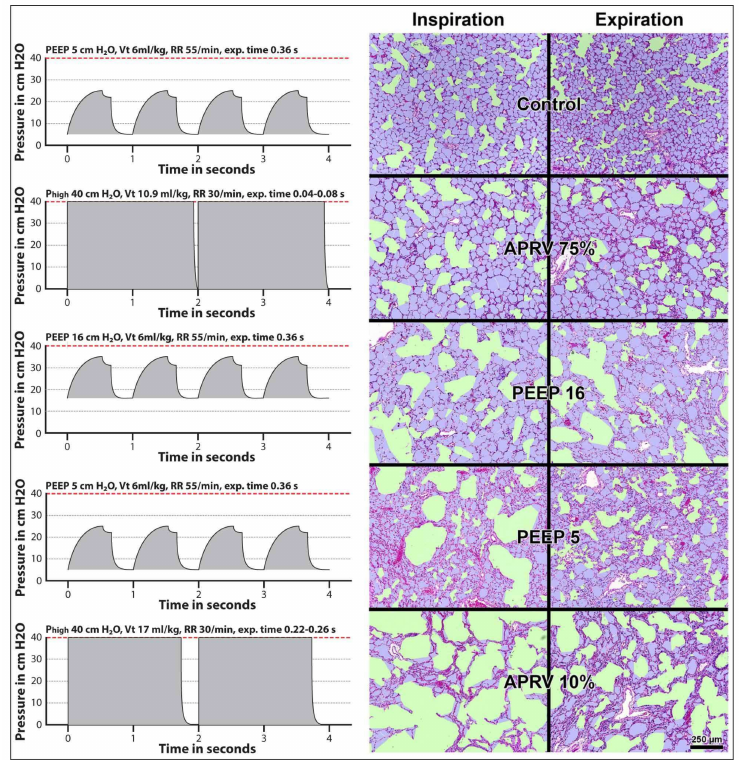
Figure 4. The effect of the ventilator settings on the alveolar mechanics. The left graphics are schematic presentations of the ventilator pressure-time curves belonging to the photomicrographs of the lung presented on the right figure. The lung was fixed at the end-inspiratory pressure (left column of the photomicrographs) and at the end-expiratory pressure (right column of the photomicrographs). The conducting airspaces including the alveolar ducts are colored green, the alveolar spaces are magenta and the alveolar walls are lilac. In APRV75% and APRV10% termination of the expiration is set at an EEF/PEF ratio of 75% and 10%, respectively. In the healthy lung using tissue microscopy after fixing the lung at peak-inspiration and at end-expiration, Kollisch-Singule, et al. (2014) demonstrated that the distribution of tidal volume between the alveoli and the alveolar ducts shows little change during inspiration and expiration (‘control’) [100]. After surfactant deactivation, there is a redistribution of air at the end of expiration from the alveoli towards the alveolar ducts (‘expiration’ and ‘PEEP 5’). During inspiration, the redistribution towards the alveolar ducts markedly increases causing a tremendous deformation of the alveoli adjacent to these alveolar ducts (‘inspiration’ and ‘PEEP 5’). This results in an increased microstrain (defined as the change in length of the alveolar ducts between inspiration and expiration normalized by their original length). Increasing the PEEP level to 16 cm H 2 O decreases the microstrain but not the redistribution of air towards the alveolar ducts (‘Inspiration’, ‘expiration’ and ‘PEEP 16’). The application of APRV10% with a P high of 40 cm H 2 O and expiratory time of 0.22–0.26 s increases the redistribution of air towards the alveolar ducts and the microstrain dramatically (‘Inspiration’, ‘expiration’ and ‘APRV10%’). By applying APRV75% with a P high of 40 cm H 2 O with a shorter expiration time 0f 0.04 to 0.08 s the redistribution of air towards the alveolar ducts and the microstrain much improve but are still not completely restored (‘Inspiration’, ‘expiration’ and ‘APRV75%’) [100]. Thus: in surfactant deactivated lung, a short expiratory time stabilizes the alveoli and a long expiratory time allows alveolar collapse to occur. By setting the timing of the termination of the expiration relative the PEF, the actual expiration time will change proportional to the time-constant of the alveoli. For instance, in slowly deflating alveoli a longer time is required to reach an EEF/PEF ratio of 75% than in fast deflating alveoli. Consequently, the expiration time in a lung with a high compliance is longer than in a lung with a low compliance. Therefore, this mode is now referred to as the ‘time-controlled adaptive ventilation’ (TCAV). APRV: airway pressure release ventilation; EEF: end-expiratory flow; PEF: peak-expiratory flow; P high : inspiratory pressure; PEEP: positive end expiratory pressure; Vt: tidal volume; RR: respiratory rate; Exp: Expiratory. Photomicrographs figure from Kollisch-Singule, et al. (2014) [100] with